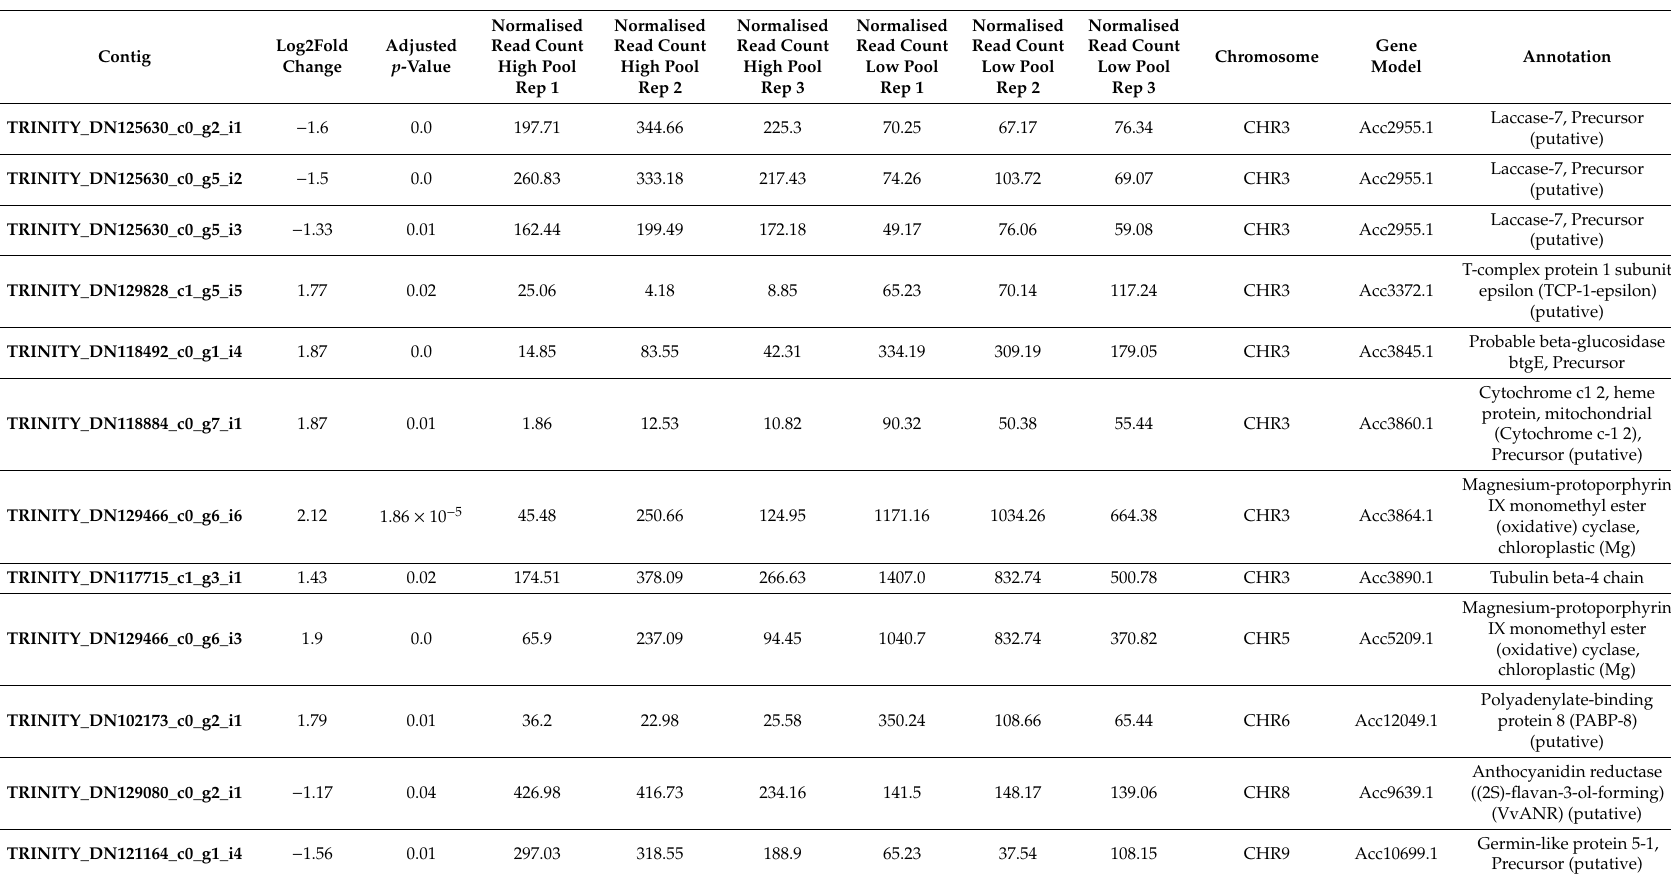
Table 1. Genome locations and associated annotations of de novo assembled transcripts not mapping to kiwifruit chromosome 26 which exhibited di ff erential expression between high and low AsA pools at FDR p <